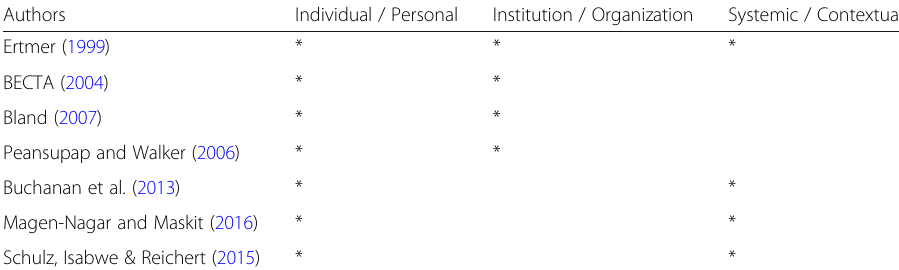
Table 1 Summary of typologies of barriers for integrating